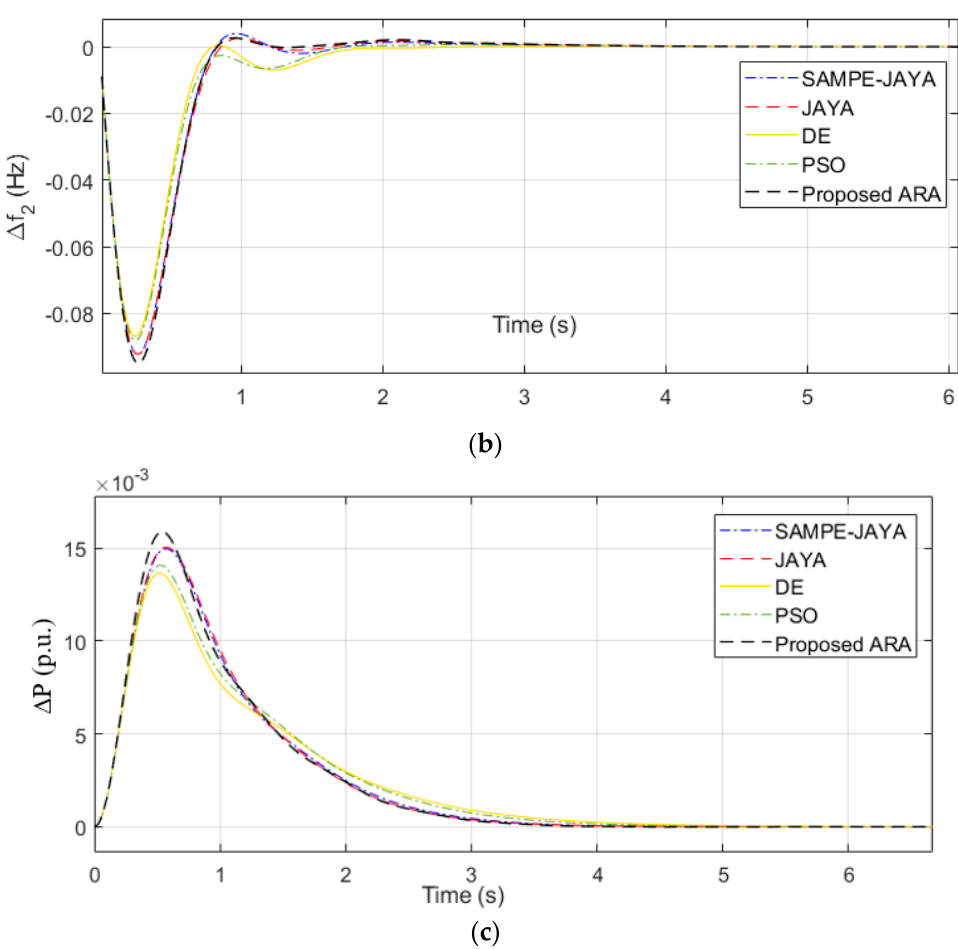
Figure 6. Dynamic responses for SAMPE-JAYA, JAYA, DE, PSO and the proposed ARA under case study 2. ( a ) Change in frequency in area 1. ( b ) Change in frequency in area 2. ( c ) Tie-line power deviation.